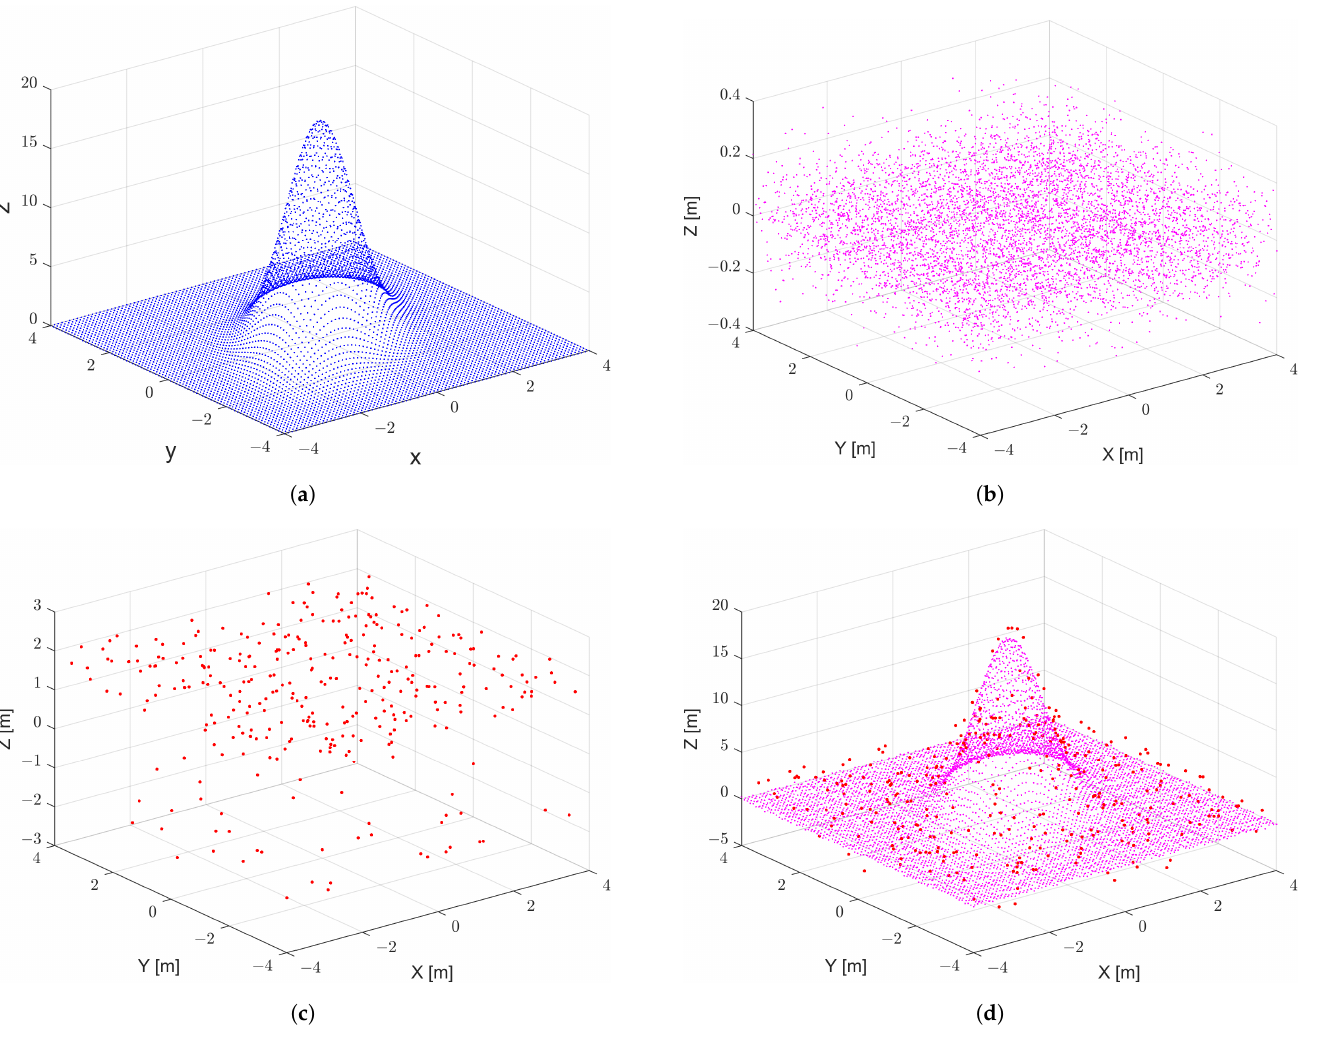
Figure 3. One realization of the simulated reference data. ( a ) Trend. ( b ) Noise. ( c ) Outliers. ( d ) Trend + Noise +